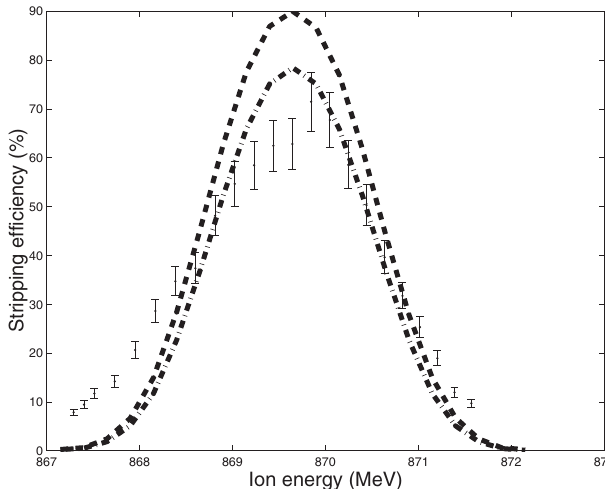
FIG. 4. Experimental points (dots with error bars), and calcu- lated dependencies (dashed and dash-dotted lines) of stripping efficiency on ion beam energy. The dashed line represents the case with the ion beam vertical size of 0.55 mm, and dash-dotted line represents the vertical size of 1.05 mm.